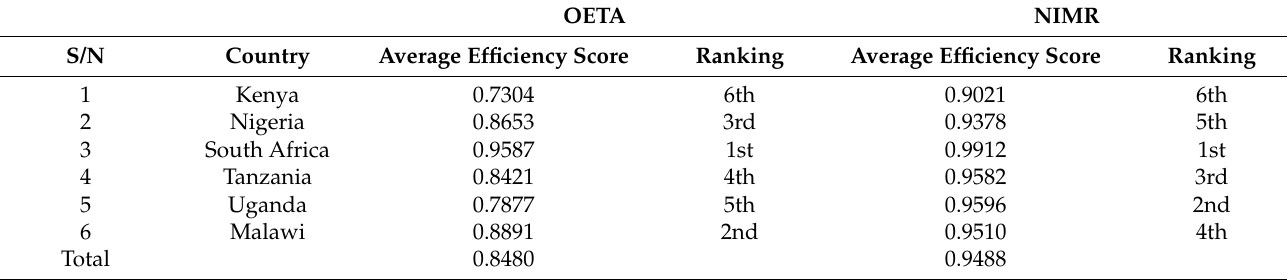
Table 5. DEA Efficiency